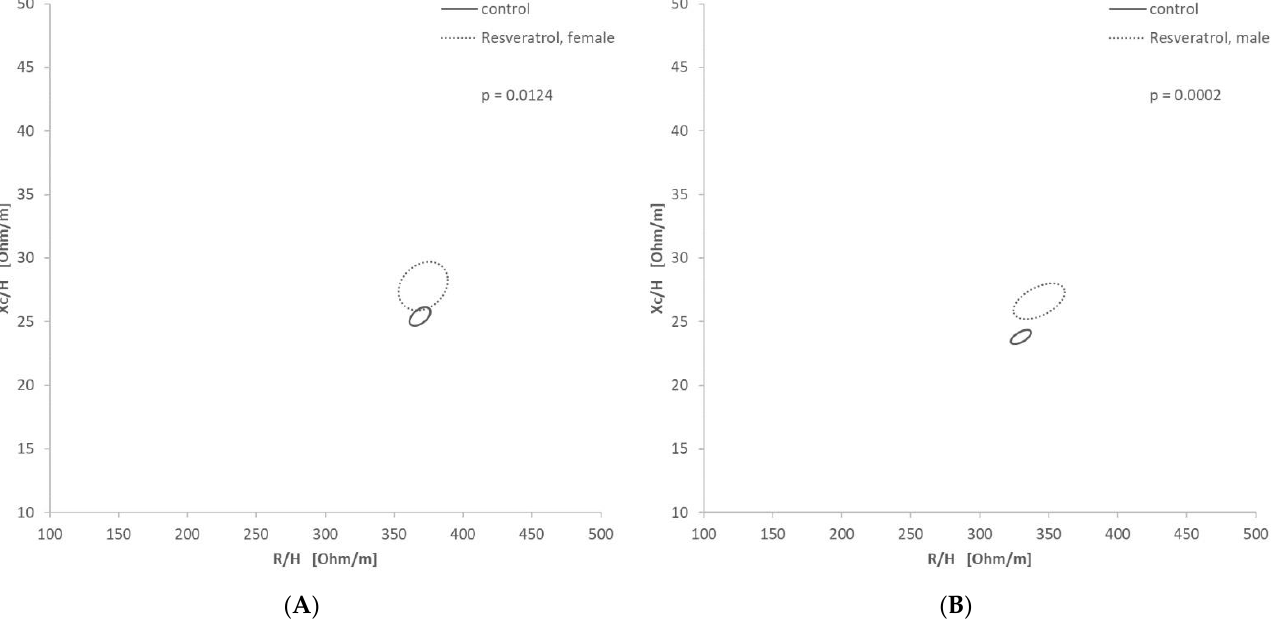
Figure 4. Confidence Ellipses in the RXc graph for resveratrol: ( A — female, B — male) Significant differentiation of male ( p = 0.0158) and female ( p = 0.0124) patients receiving resveratrol.